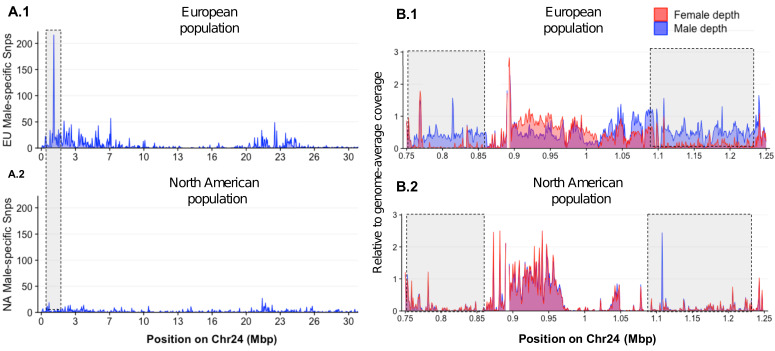
Loss of the ancestral sex locus and master sex determination gene in North American northern pike.(A) The numbers of male-specific SNPs in 50 kb non-overlapping windows deduced from Pool-Seq data of a European population (A.1) and North American population (A.2) of E. lucius were mapped to the Y chromosome (LG24) of the sequence of E. lucius from a European male genome (SDAW00000000). The greatest number of male-specific SNPs is found in a single window located at the proximal end of LG24 (0.95 Mb–1.0 Mb) that contains 182 male-specific SNPs (highlighted by the gray box) in the European E. lucius population. The same region, however, shows no differentiation between males and females in the North American population. (B) Relative coverage of male and female Pool-Seq reads is indicated by blue and red lines, respectively, in contigs containing amhby in the European population (B.1) and in the North American population (B.2). Only zoomed view on the European population sex-specific region is presented to facilitate the visualization of the differences in coverage between two populations. We searched for Y-specific regions in 1 kb windows. A window is considered Y specific if it is covered by few mapped female reads (<3 reads per kb) and by male reads at a depth close to half of the genome average (relative depth between 0.4 and 0.6). Based on these depth filters, in the European population we identified 70 potential Y-specific 1 kb windows located between 0.76 Mb and 0.86 Mb and 70 Y-specific 1 kb windows located between 1.0 Mb and 1.24 Mb on LG24. This region is not covered by male or female reads in the North American population, indicating the loss of the entire Y-specific region, highlighted by the gray boxes. The region between 0.86 Mb and 1.0 Mb is not sex specific in both population and is likely an assembly artifact. Figure 4—source code 1.R script to generate Figure 4.Figure 4—source data 1.Pool-Seq comparison of sex-specific SNPs in windows of 50 kb between males and female from a European population of E. lucius.Figure 4—source data 2.Pool-Seq comparison of sex-specific coverage in windows of 1 kb between males and female from a European population of E. lucius.Figure 4—source data 3.Pool-Seq comparison of sex-specific SNPs in windows of 50 kb between males and female from a North American population of E. lucius.Figure 4—source data 4.Pool-Seq comparison of sex-specific coverage in windows of 1 kb between males and female from a North American population of E. lucius.Figure 4—source data 5.E. lucius chromosome length file for the R script.